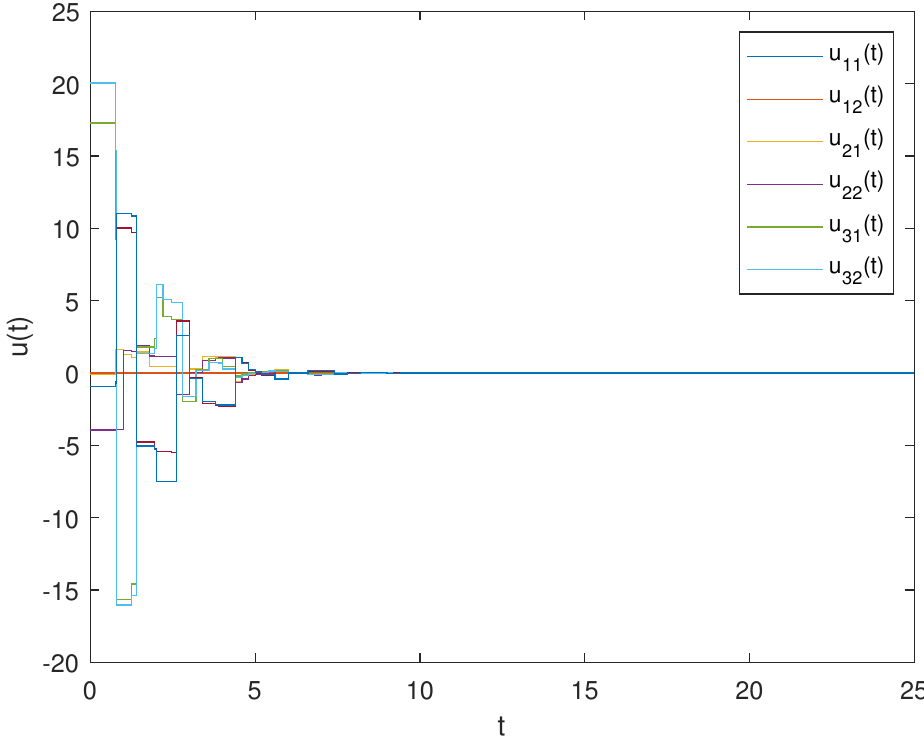
Figure 17. The state trajectory of improved event-triggering control input in Example 2. Under the improved event-triggered control, the state trajectory of the control input variables was